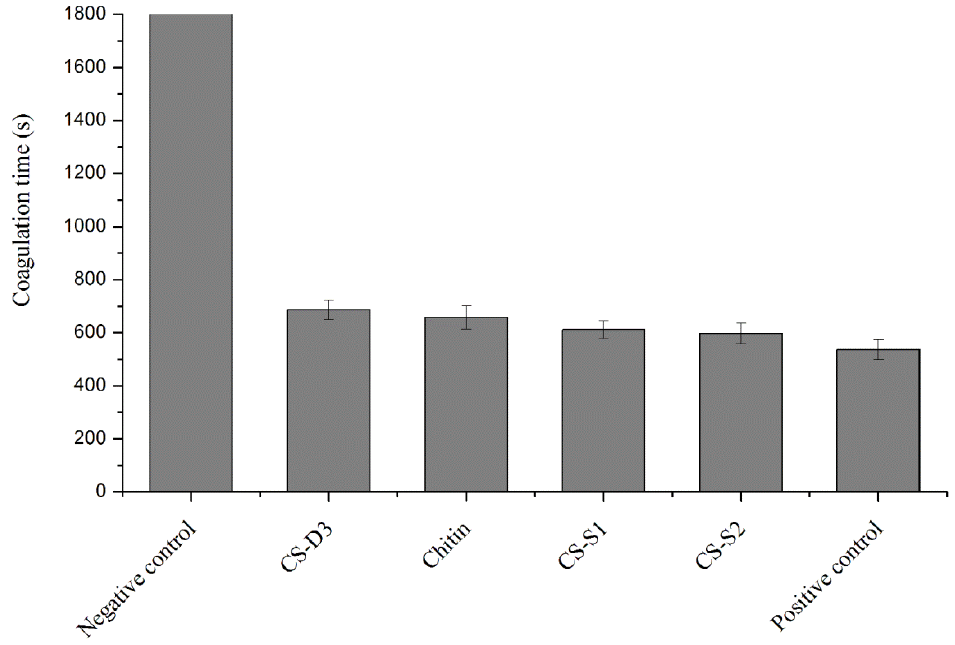
Figure 6. Effect of chitosan acid salts on coagulation time. From the comparison between CS-A2 and CS-A3, CS-A3 showed better performance in promoting coagulation, which was consistent with that reported in the literature [42]. This was probably because lactate, with a lower acidity coefficient (3.85) than that of acetic acid (4.75), had stronger ability to transfer protons and to form protonated amino groups.